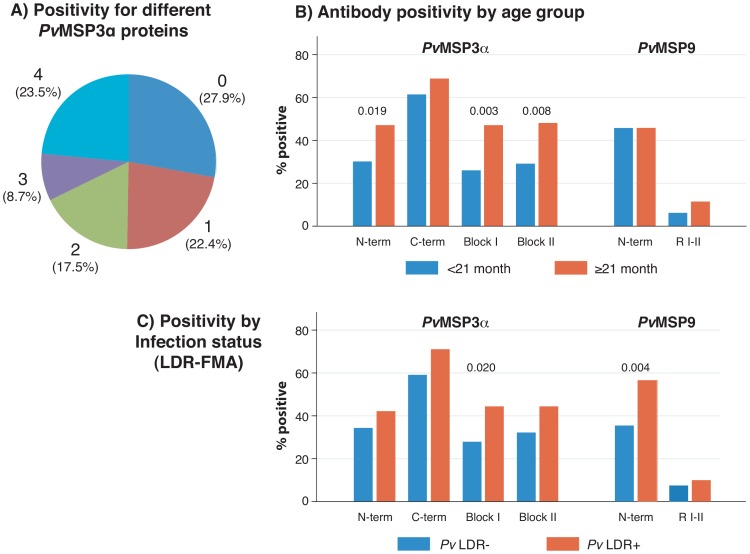
IgG positivity to different PvMSP3α and PvMSP9 proteins.(a) Cumulative IgG positivity for different PvMSP3α proteins. Data are plotted as the percentage of 183 individuals who are antibody positive for 0–4 of the proteins tested. (b) Associations between age and IgG positivity to PvMSP3α and PvMSP9 proteins. Children were divided into two age groups (<21 mths: n = 96, ≥21 mths: n = 87) to examine associations with age. P values≤0.05 were considered significant and are shown. (c) Associations between P. vivax infection status (post-PCR LDR-FMA positive: n = 90, negative: n = 93) and IgG positivity to PvMSP3α and PvMSP9 proteins. As indicated, the presence of P. vivax was determined by a semi-quantitative post-PCR ligase detection reaction-fluorescent microsphere assay (LDR-FMA). P values≤0.05 were considered significant and are shown.